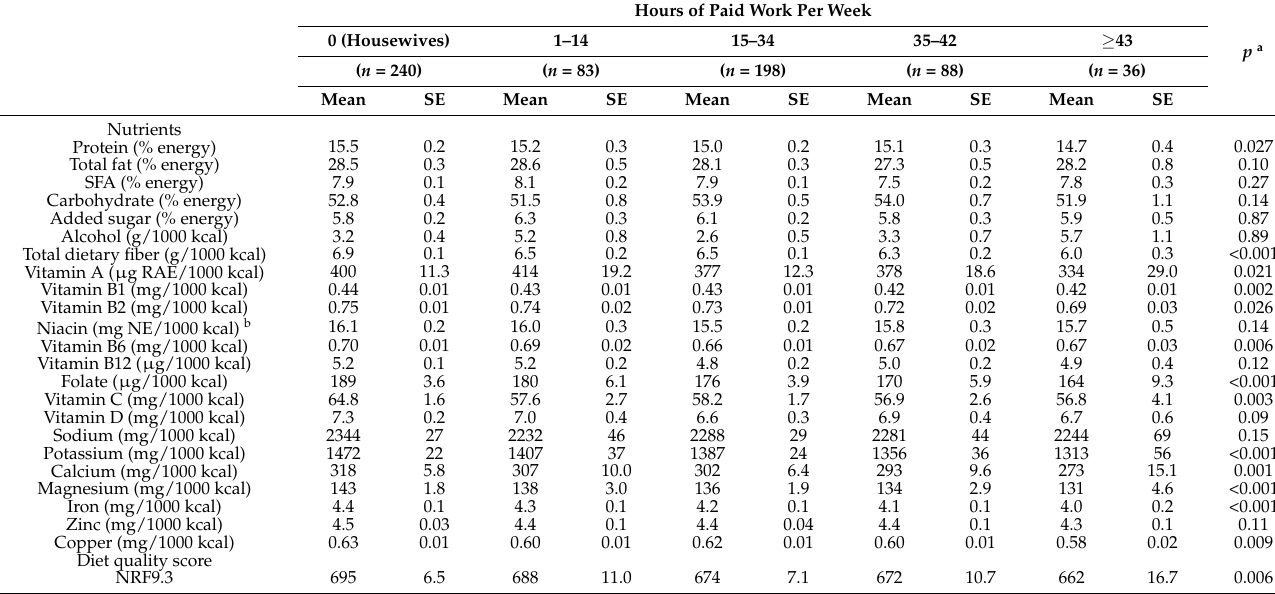
Table 3. Nutrient intake and NRF9.3 score according to the categories of hours of paid work in 644 Japanese married